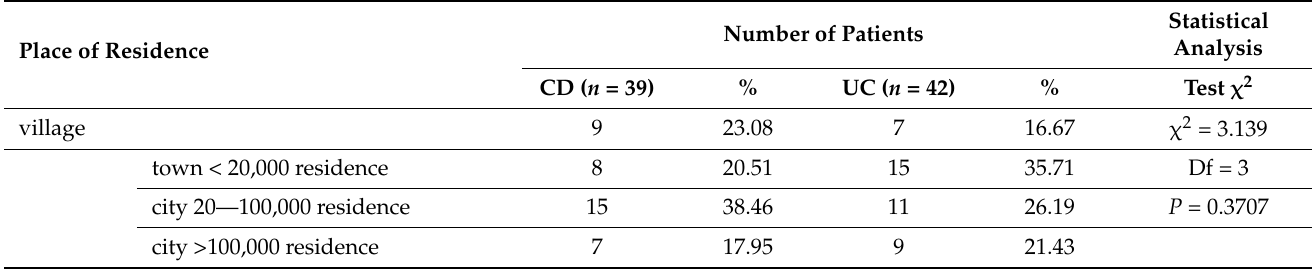
Table 6. Correlation between type of IBD and place of